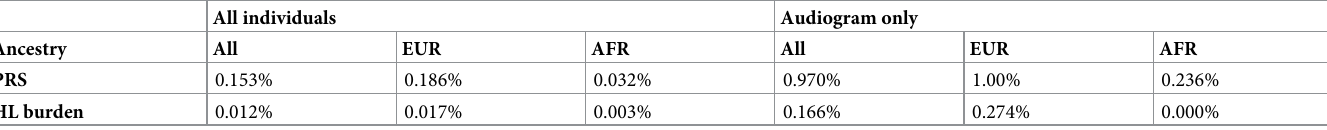
Table 5. Predictive power (incremental R 2 ) of polygenic risk scores and burden of deleterious variants in known HL genes for degree HL in PMBB. All